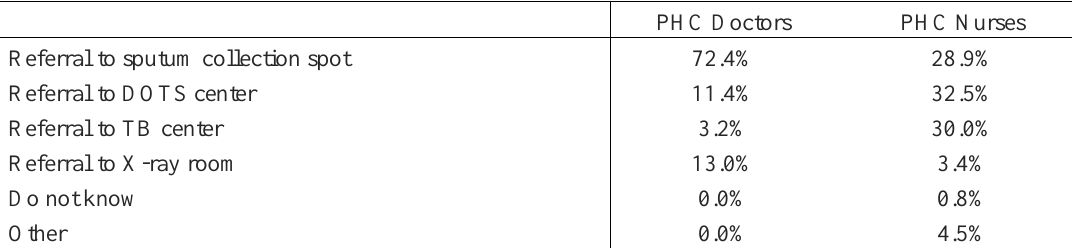
Table 2.Suggested actions of PHC providers toward TB